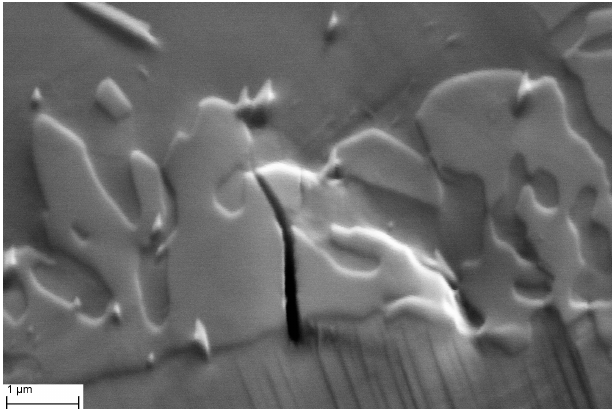
Figure 7. Micro-crack formed in the σ -phase during the initial stages of deformation. This frame is acquired after 6% strain, during the low temperature test with 5% σ